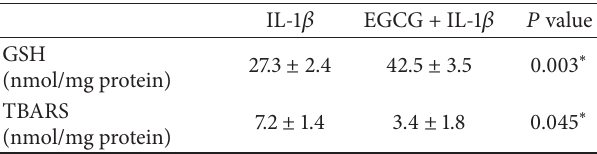
Table 2: The GSH and TBARS levels in EGCG and IL-1 𝛽 -treated